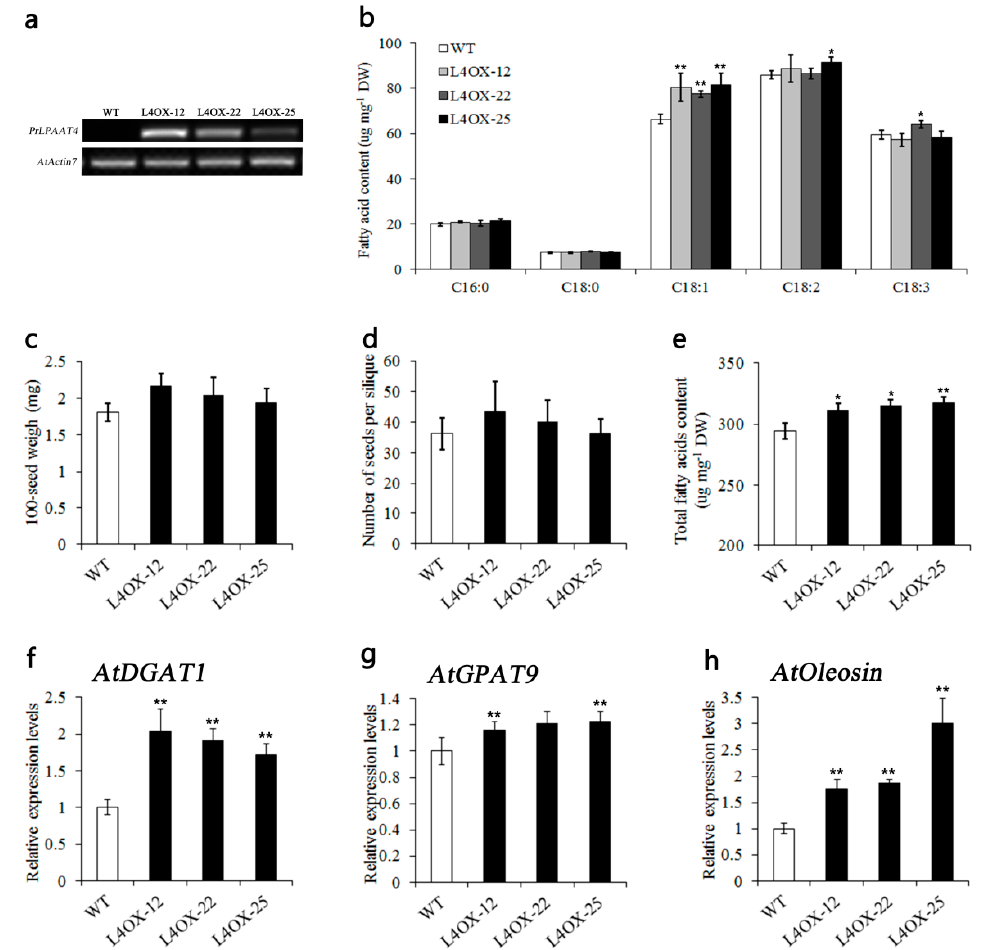
Figure 6. Effect of PrLPAAT4 overexpression on plant growth, FA content and composition of transgenic Arabidopsis seeds. ( a ) semi-quantitative RT-PCR analysis of PrLPAAT4 transcript abundances in the seeds of transgenic Arabidopsis lines overexpressing PrLPAAT4 , compared to WT; ( b ) main FA content; ( d ) number of seeds per silique; ( c ) 100-seed weight; ( e ) total FA content; ( f–h ) quantitative real-time PCR analysis of AtDGAT1 ( f ); AtGPAT9 ( g ); and AtOleosin ( h ) expression levels in PrLPAAT4 -overexpressing transgenic Arabidopsis plants. Error bars represent the mean ± SD of three independent biological replicates. Atactin7 was used as a reference gene. Asterisks denote significant difference using Student’s t test. * indicates p < 0.05; ** indicates p < 0.01.